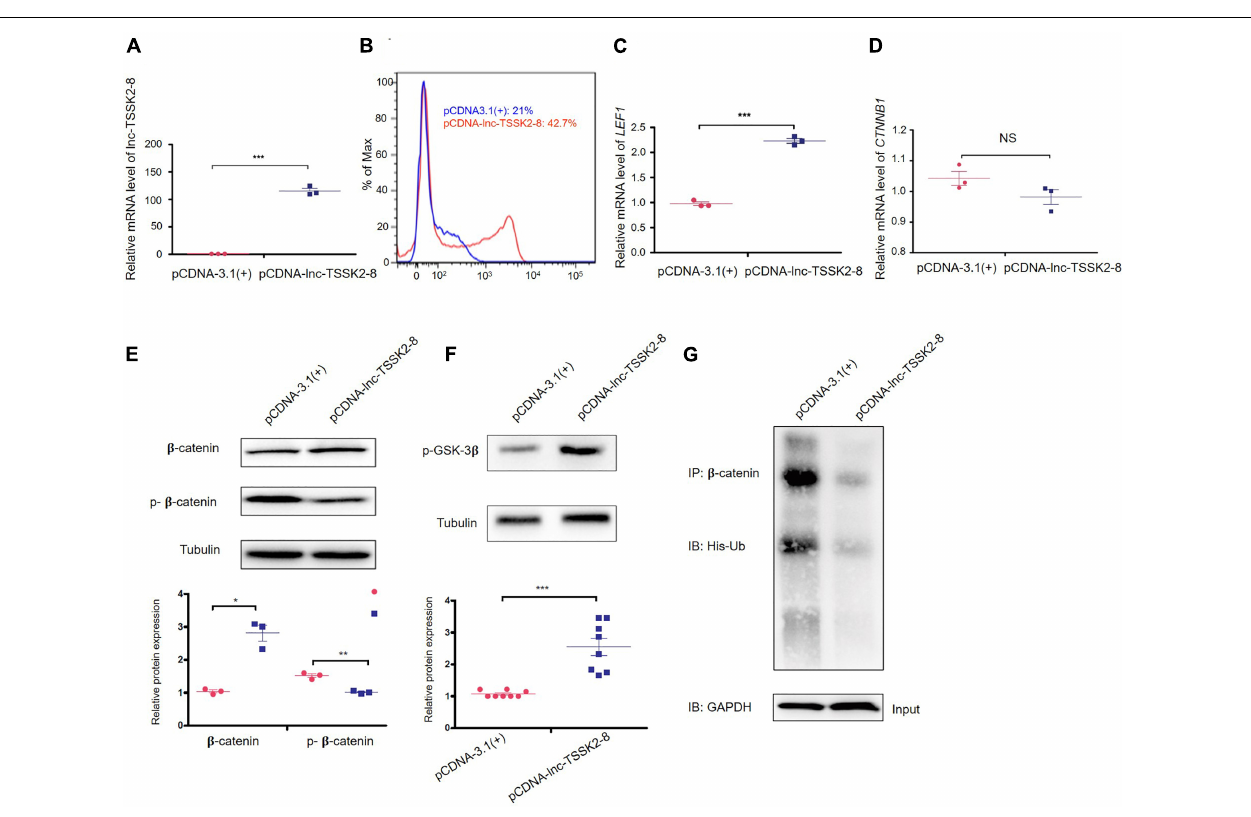
FIGURE 2 | Overexpression of lnc-TSSK2-8 activates the Wnt/ β -catenin signaling pathway. (A) RT-qPCR quantification of overexpression lnc-TSSK2-8 in HEK293 cells. (B) Flow cytometry analysis of cell proliferation. The transcriptional level of lymphoid enhancer-binding factor 1 ( LEF1 ) (C) and β -catenin ( CTNNB1 ) (D) in HEK293 cells with lnc-TSSK2-8 overexpression. (E) The influence of lnc-TSSK2-8 overexpression on protein expression and phosphorylation of β -catenin. (F) The influence of lnc-TSSK2-8 overexpression on the activity of glycogen synthase kinase 3 β (GSK-3 β ). (G) The influence of lnc-TSSK2-8 overexpression on ubiquitination of β -catenin. * p < 0.05, ** p < 0.001, ** p <